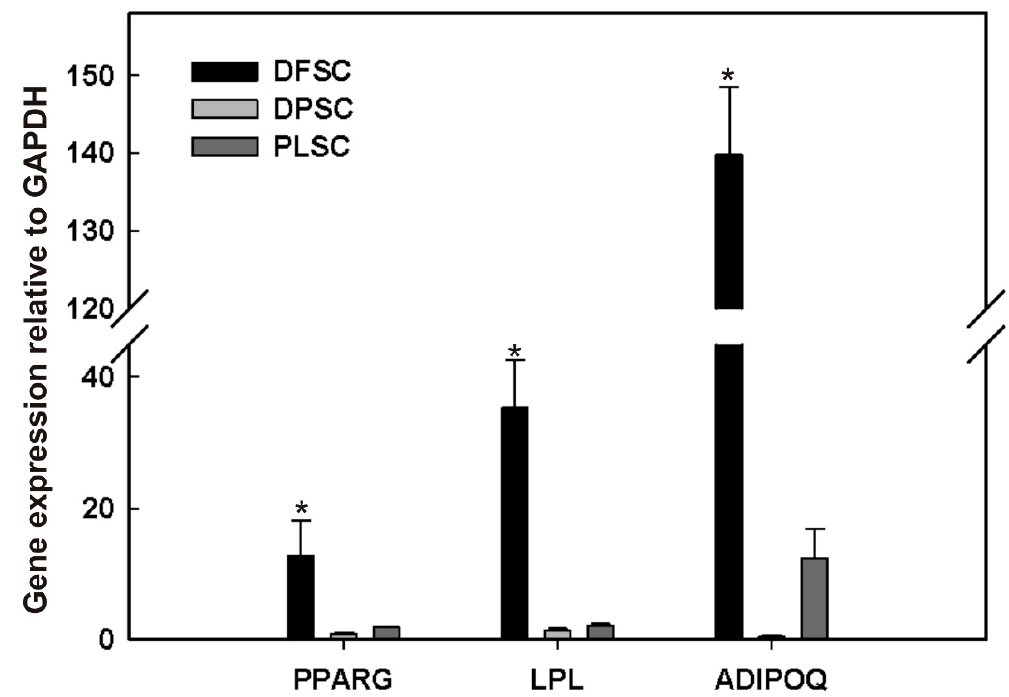
Figure 7. Quantitative PCR analysis of the expression of adipogenic markers PPARG , LPL , and ADIPOQ in cultured dental follicle stem cells (DFSCs), dental pulp stem cells (DPSCs), and periodontal ligament stem cells (PLSCs) under adipogenic conditions after three weeks in the AIM-3 medium ( n = 3). Error bars represent the standard deviation of the mean from three independent experiments Asterisks (*) represent significance with respect to the adjacent cell group ( p < 0.05).